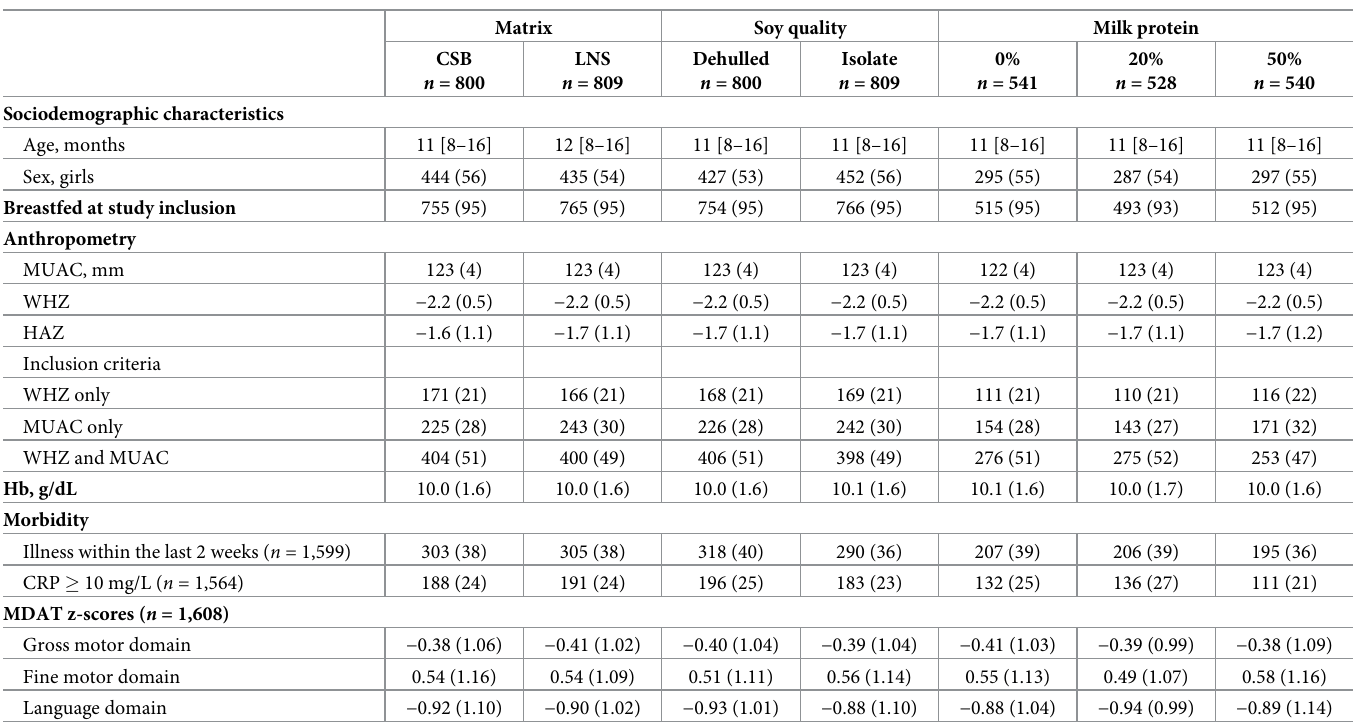
Table 1. Baseline characteristics of 1,609 children with MAM.